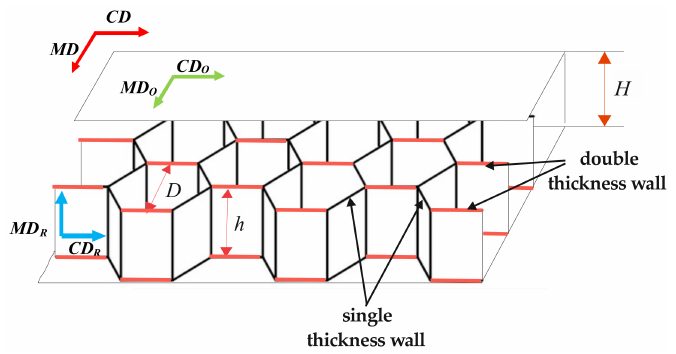
Figure 2. Construction of a cellular paperboard with a honeycomb core [43].